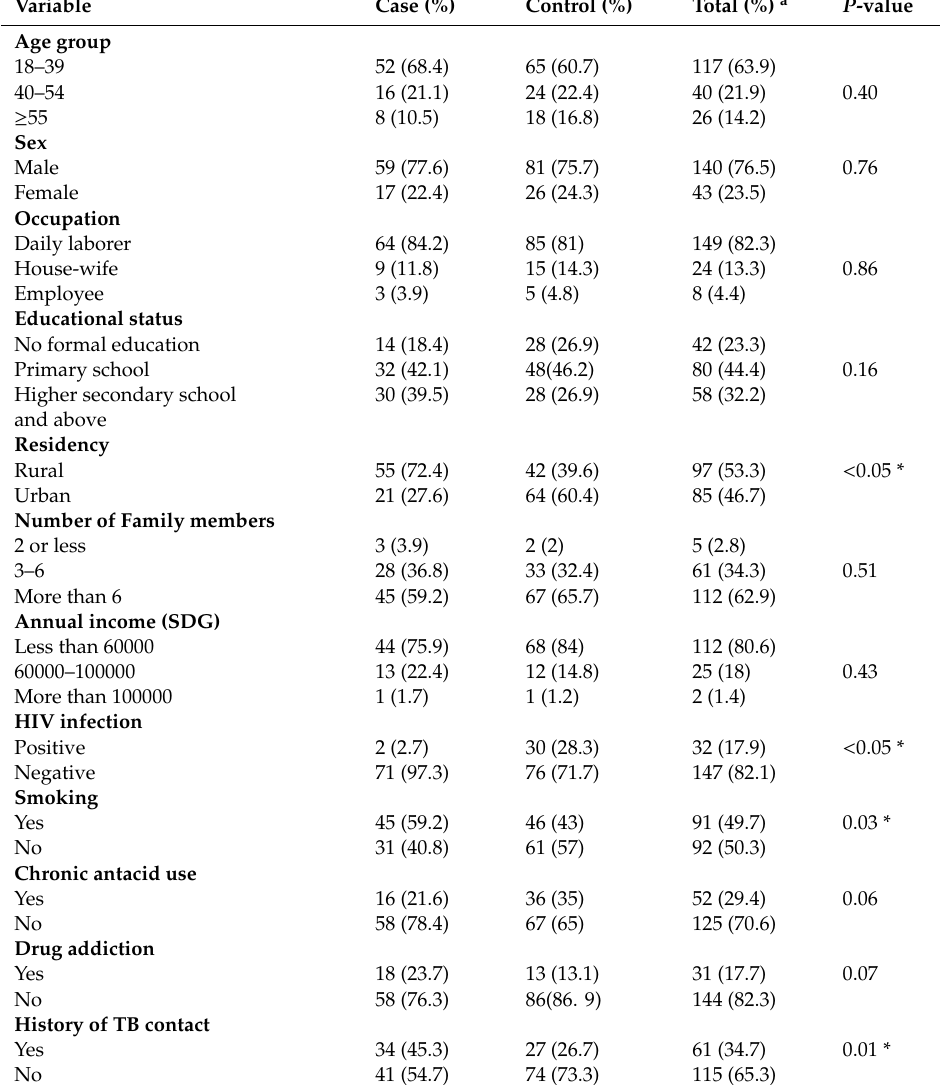
Table 1. Socio-demographic and clinical characteristics of the study